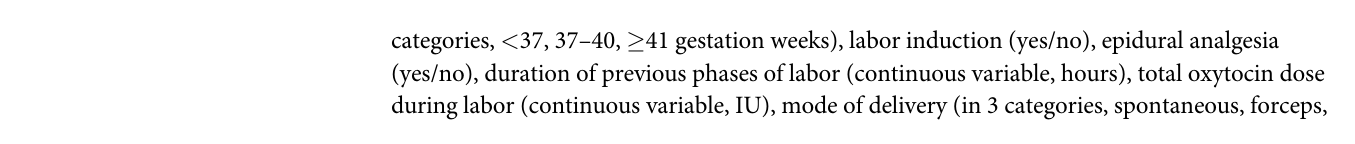
Fig 1. Flow chart. Characteristics of the women, of labor, of delivery and birth weight of the baby were collected from the medical file. Characteristics of the maternity units were collected from a specific questionnaire.